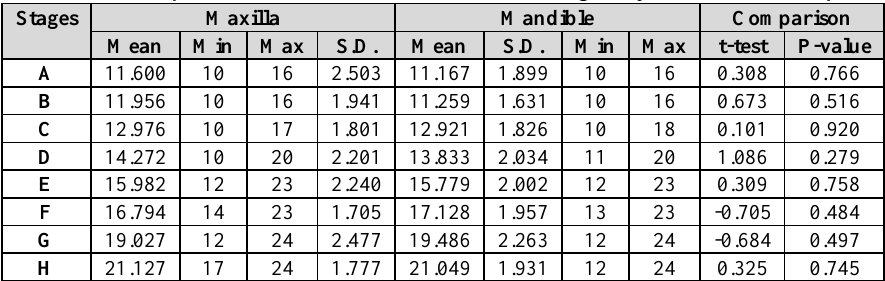
Table 2: Descriptive statistics and arch difference of the age (in years) in whole sample. Stages